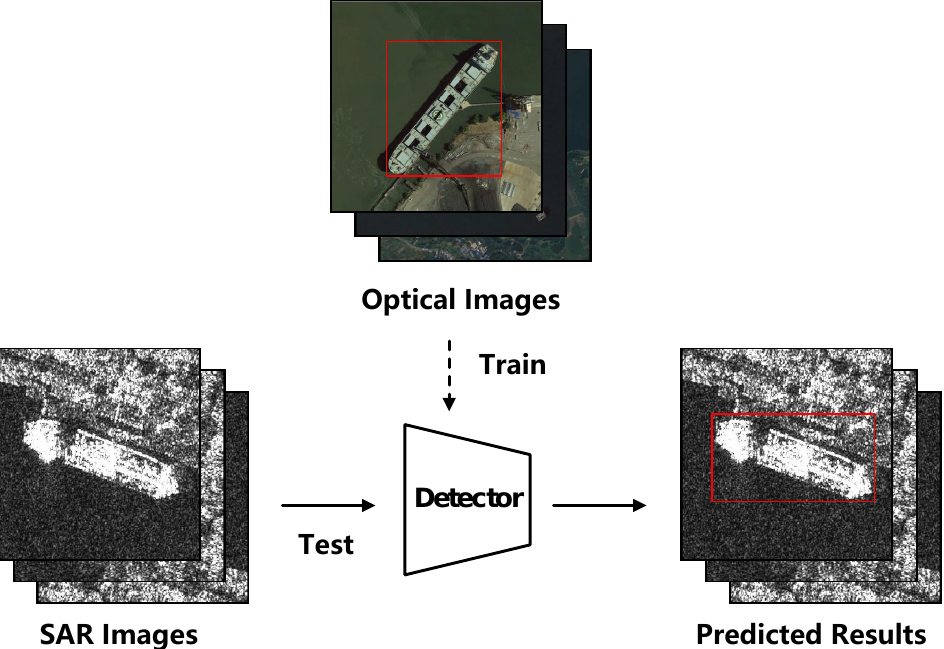
Figure 2. The cross-domain ship detection task. Full supervision is given in the optical domain while no supervision is available in the SAR domain. The detector is trained in the optical domain but is adapted for the SAR